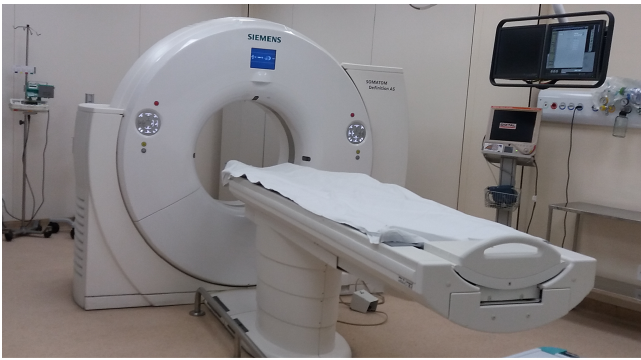
Figure 17. MRI/CT scanner room.